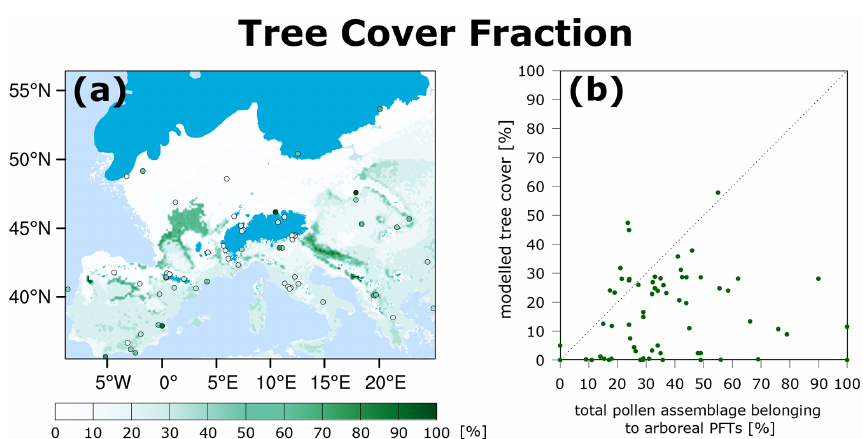
Figure 6. Comparison between modelled and reconstructed tree cover. Panel (a) shows the LPJ-LMfire-simulated tree cover fraction from LGM LGM . Circles represent the 71 pollen samples securely dated to LGM from Kaplan et al. (2016). Panel (b) shows a scatter plot of reconstructed vs. modelled LGM tree